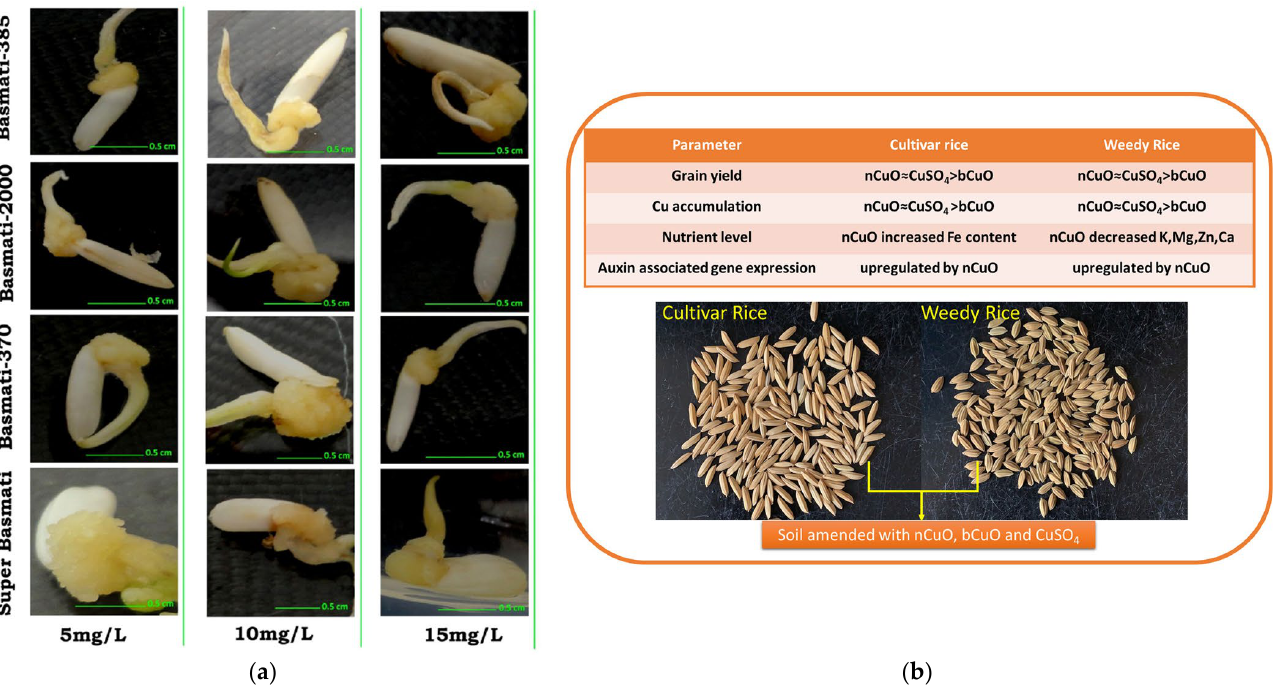
Figure 5. ( a ) Effect of copper oxide nanoparticles (5 mg/L, 10 mg/L, and 15 mg/L) on rice healing tissue production. Reprinted with permission from Ref. [55]. 2016, Frontiers; ( b ) copper oxide nano-